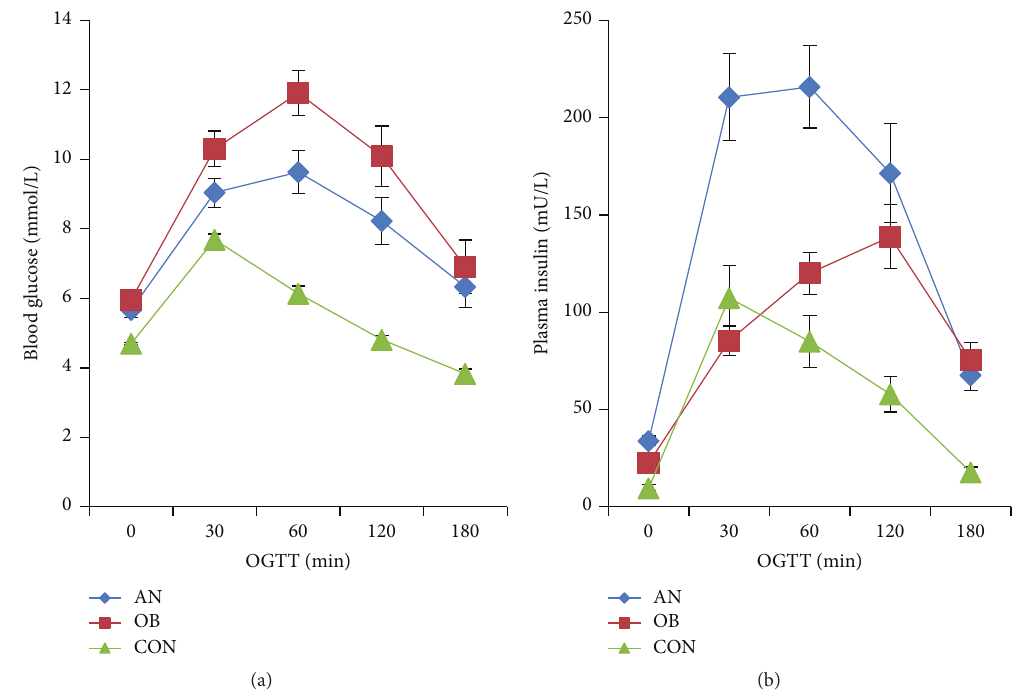
Figure 1: Change of glucose and insulin among 3 groups in OGTT. (a) Compared with CON group, AN group and OB group had higher blood glucose at each point ( 𝑃 < 0.05 ). Compared with AN group, OB group had higher level of glucose at each point, but the difference was not significant. (b) Compared with CON group, OB group had higher level of insulin at four points (0min, 1h, 2h, and 3 h) ( 𝑃 < 0.05 ) and AN group had higher level at each point ( 𝑃 < 0.05 ). Compared with OB group, AN group had higher level of insulin at three points (0min, 30 min, and 1h) ( 𝑃 < 0.05 ). Graphs depict the value of mean and SEM. OB: simple obese group. AN: obese group with acanthosis nigricans. CON: control